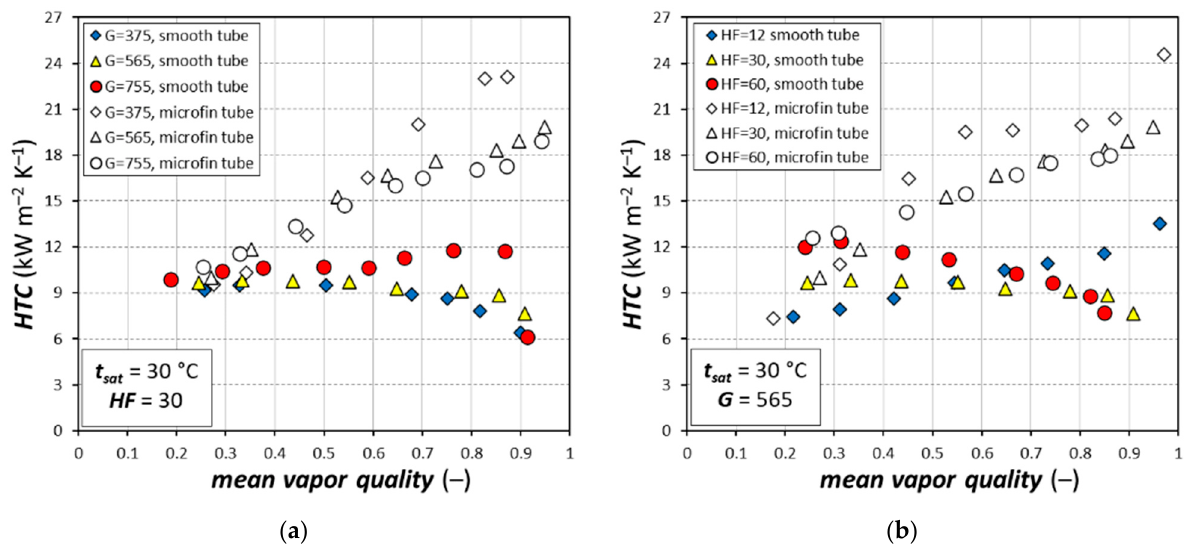
Figure 7. Comparison between heat transfer coefficient of smooth tube and microfin tube. ( a ) Data at t sat = 30 °C and HF = 30 kW m − 2 at different mass velocity; ( b ) data at t sat = 30 °C and G = 565 kg m − 2 s − 1 at different heat flux. Data for the microfin tube are borrowed by Diani et al. [21].